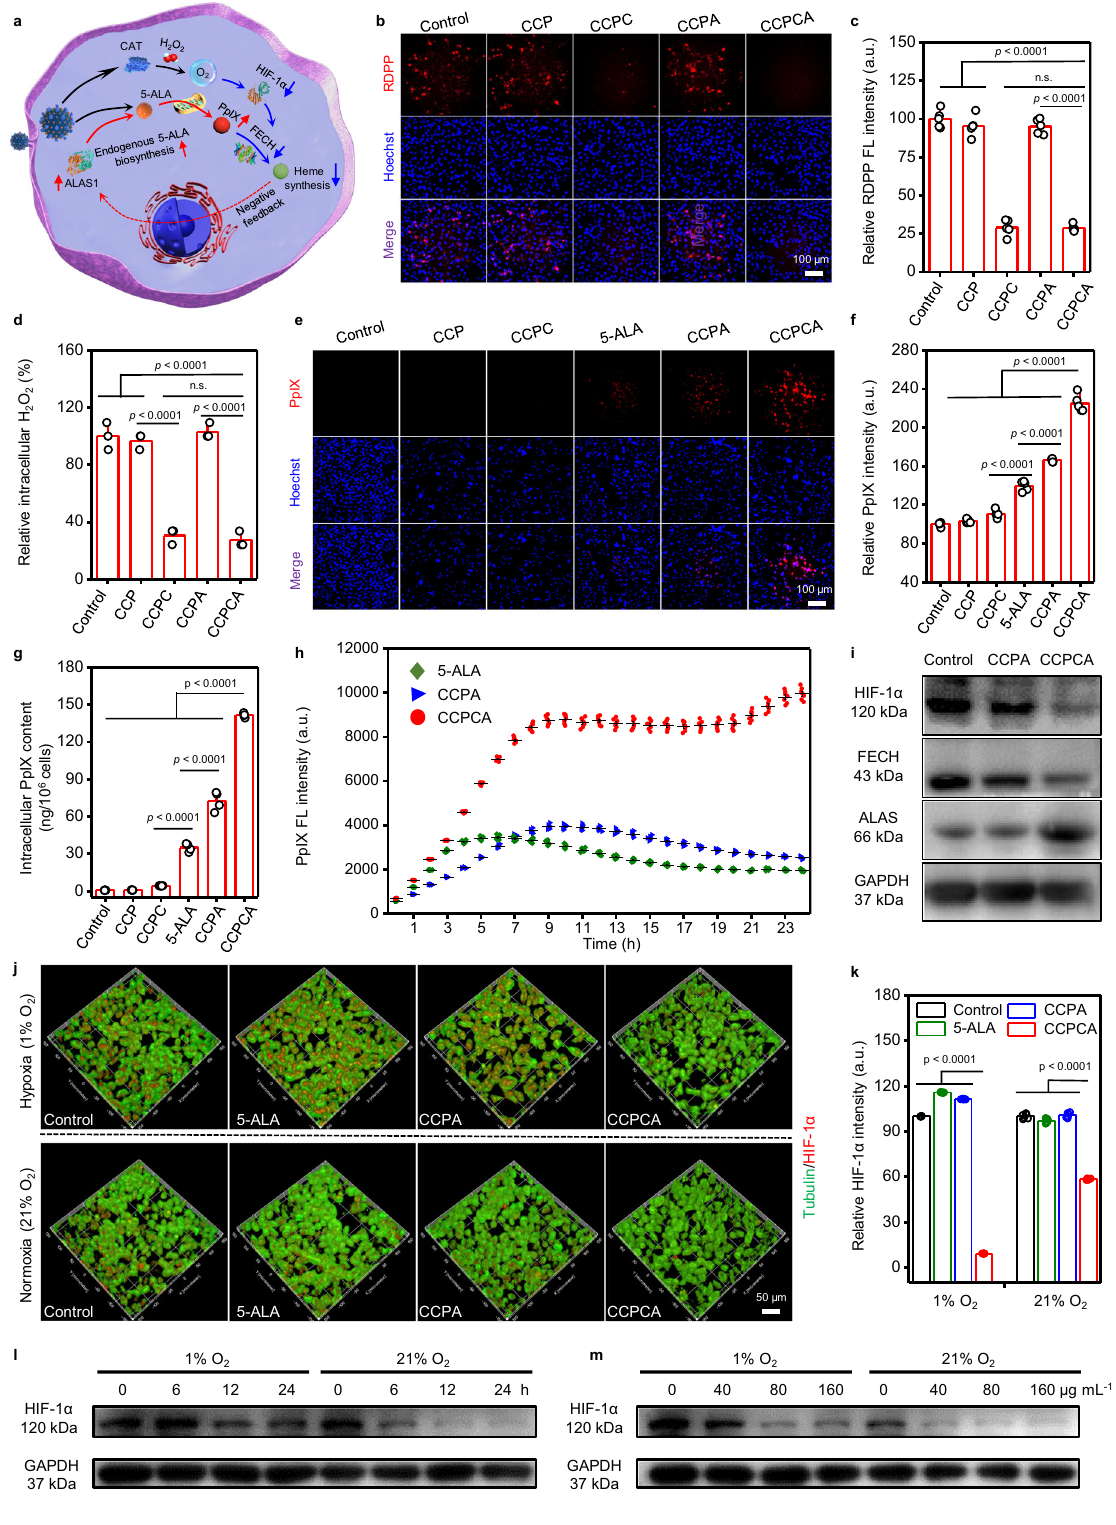
A375 and malignant glioblastoma U87MG cells(Fig. 4c,d). By contrast, CCPA NPs-treated A375 and U87MG cells showed improved viabilities under the same laser irradiation conditions and 5-ALA dosage. Flow cytometric analysis of cell apoptosis further con fi rmed the fi ndings of dark cytotoxicity and phototoxicity assays, combined with ~2 – 3-fold higher levels of apoptotic A375 cells after CCPCA + Laser (+) than 5-ALA (+ ) and CCPA (+) treatment (Fig. 4e) under normoxia